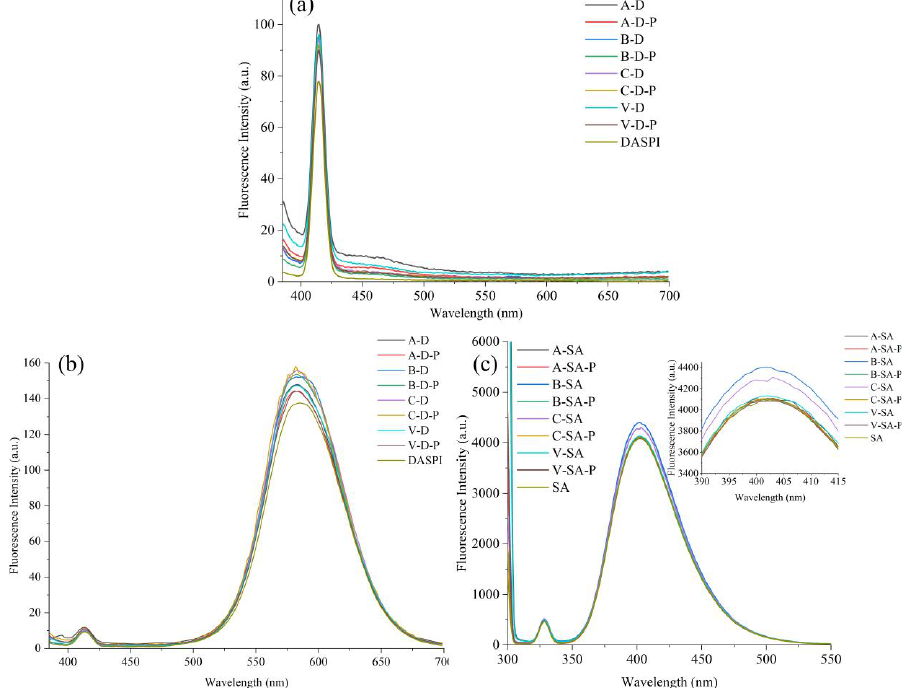
Figure 1. Screening of the fluorescence spectra of ( a , b ) DASPI and ( c ) SA dyes. ( a , b ) The solutions after sonication of A–, B–, C–, and V–type starches and DASPI are labeled A–D, B–D, C–D, and V–